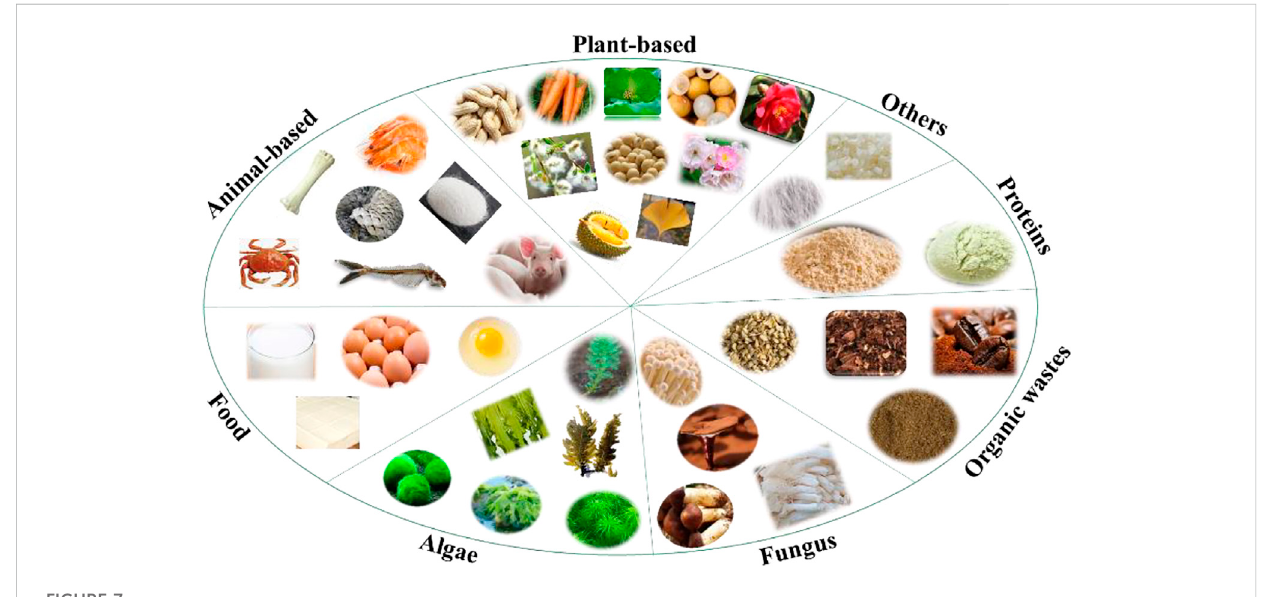
N-rich biomass involved in existing